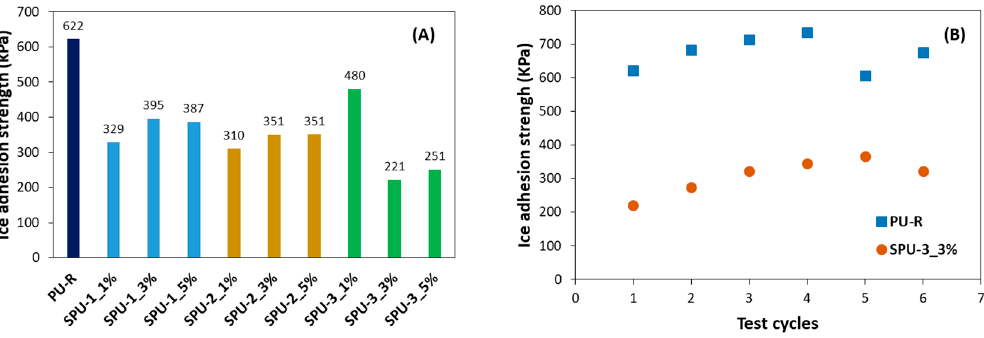
Figure 5. Ice adhesion strength (in kPa) of SPU coatings measured using a static push rig at − 14 °C ( A ) and ice adhesion strength of PU-R and SPU-3_3% coatings that were subjected to repeated icing/ice removal cycles ( B ).